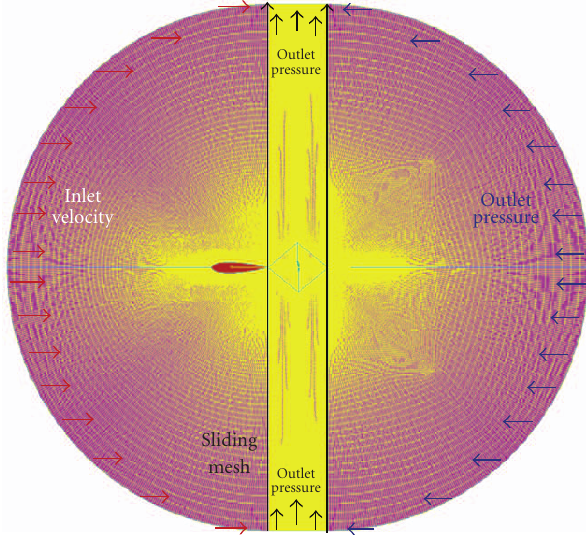
Figure 3: Computational domain and the assigned BC.